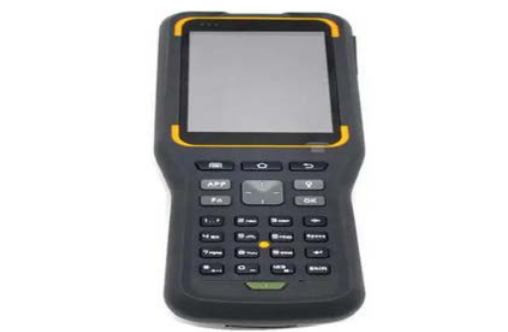
Figure 8. starfish irtk5x observation manual